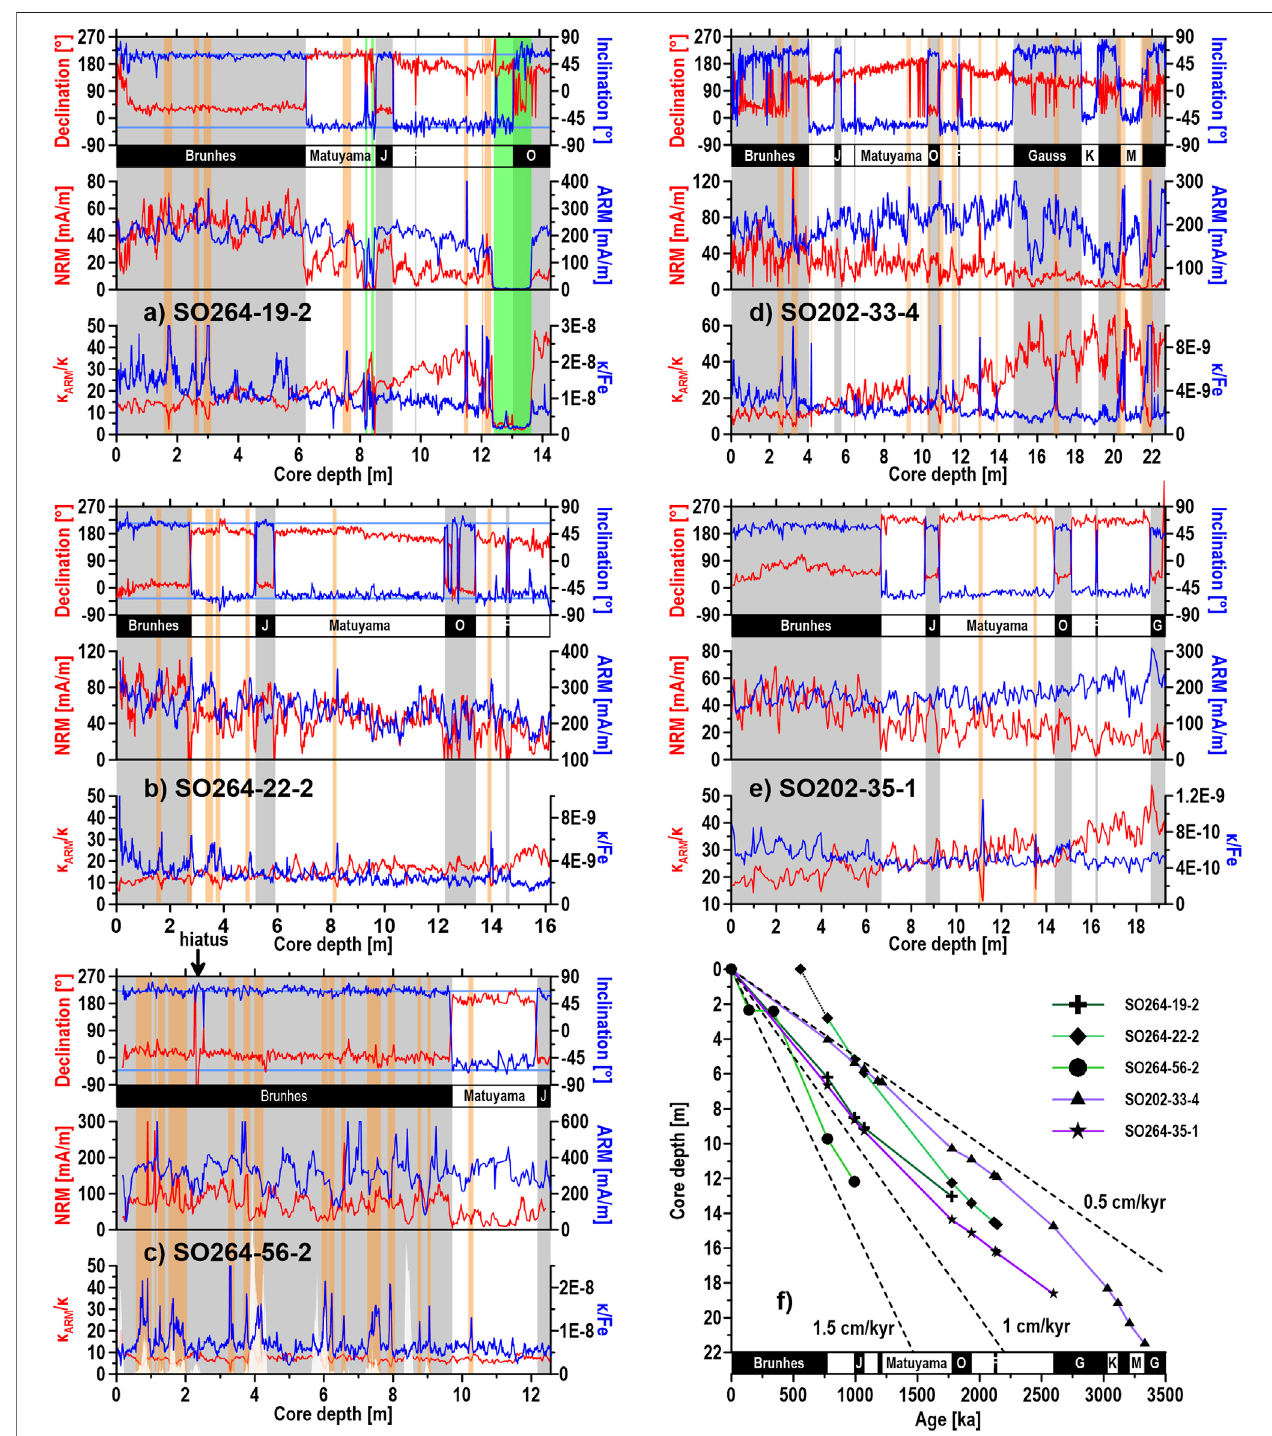
FIGURE6| Magnetostratigrapicandrock magneticrecordsofcores (A) SO264-19-2, (B) SO264-22-2, (C) SO264-56-2, (D) SO202-33-4, and (E) SO202-35-1. Ineachplot,theazimuth-correcteddeclinationandinclination,NRMandARMintensity,and κ ARM / κ and κ /Fearemarkedbyredandbluelines,respectively.Greenbands markdissolutionlayers,orangebandsvolcaniclasticlayers.Whitepeaksin (C) arecarbonatelayersgivenas[Ca/Si].thelightbluelinesin (A-C) arethelocalinclinationsof a geocentric axial dipole. Magnetostratigraphic names and interpretations follow the Ogg (2020) GPTS 2020. Black/gray (white) bars represent normal (reverse) polarity zones. Magnetostratigraphic abbreviations: J — Jaramillo Subchron, CM — Cobb Mountain Subchron, O — Olduvai Subchron, F — Feni Subchron, K — Kaena Subchron,Mammoth Subchron,G — GaussChron. (F) Age-depth plots ofallcores.Symbolsrepresent geomagneticreversals.The dotted lineofcore SO264-22-2 isa backward extrapolation from the following reversals. Dashed lines represent sedimentation rates.